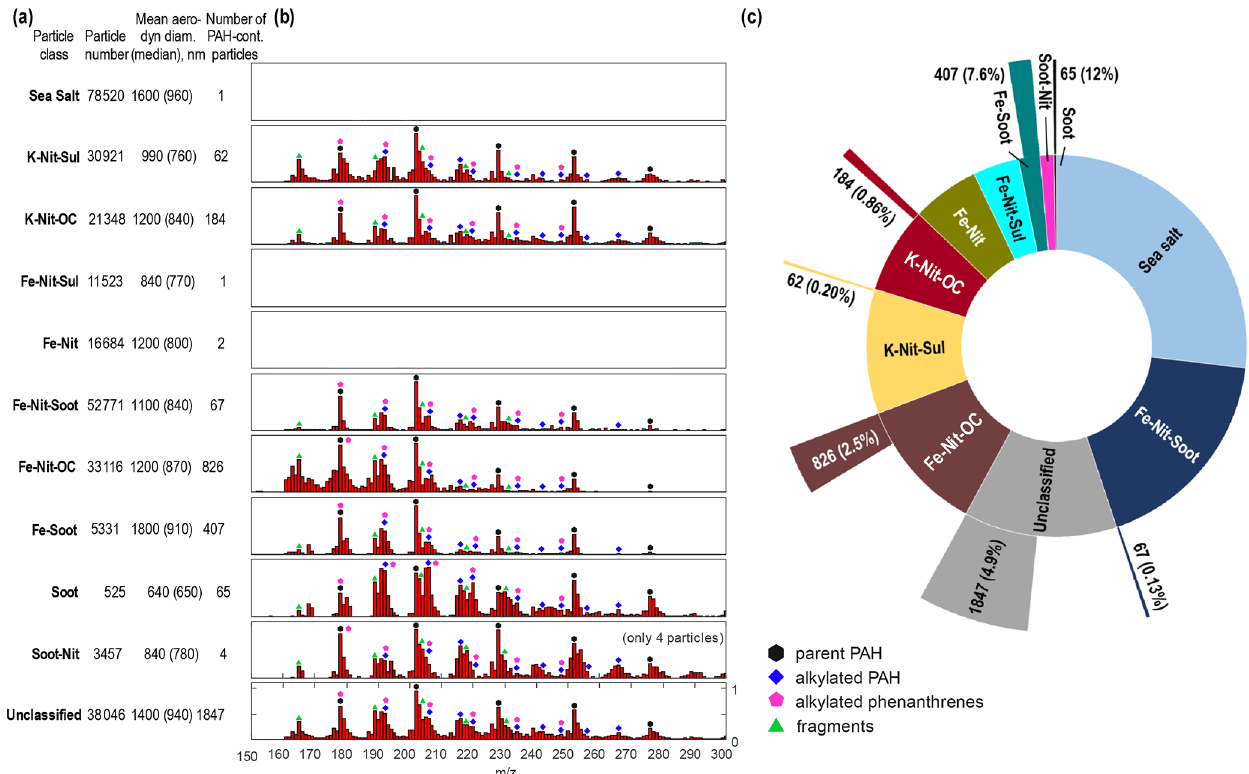
Figure 4. (a) Main particle classes obtained from ART-2a clustering of LDI mass spectra, their particle numbers, size and the number of PAH-containing particles in the respective class. Sea salt particles and mixtures with strong secondary nitrate and sulfate rarely show PAHs. (b) Averaged REMPI mass spectra of the respective LDI clusters. Particles with dominating potassium signatures reveal strong signals of high-mass PAHs, e.g., from wood combustion, while particles with prominent Fe signatures show more alkylated and smaller PAHs, as typical for diesel emissions (Zhang et al., 2008; Tobiszewski and Namie´snik, 2012). Fresh soot particles have higher signals of alkylated phenanthrenes. The unclassified particles were not within the top 300 ART-2a clusters but reveal variable LDI signatures, mostly from organic fragments. Particles with less than four peaks in LDI spectra are not shown here, explaining the missing PAH-containing particles. (c) The inner ring of the sunburst plot illustrates the relative abundance of each LDI-determined particle class. The outer ring depicts the absolute number and number fraction of PAH-containing particles in the respective class. The areas of the outer ring are 10-fold enlarged to make small fractions of PAH-containing particles